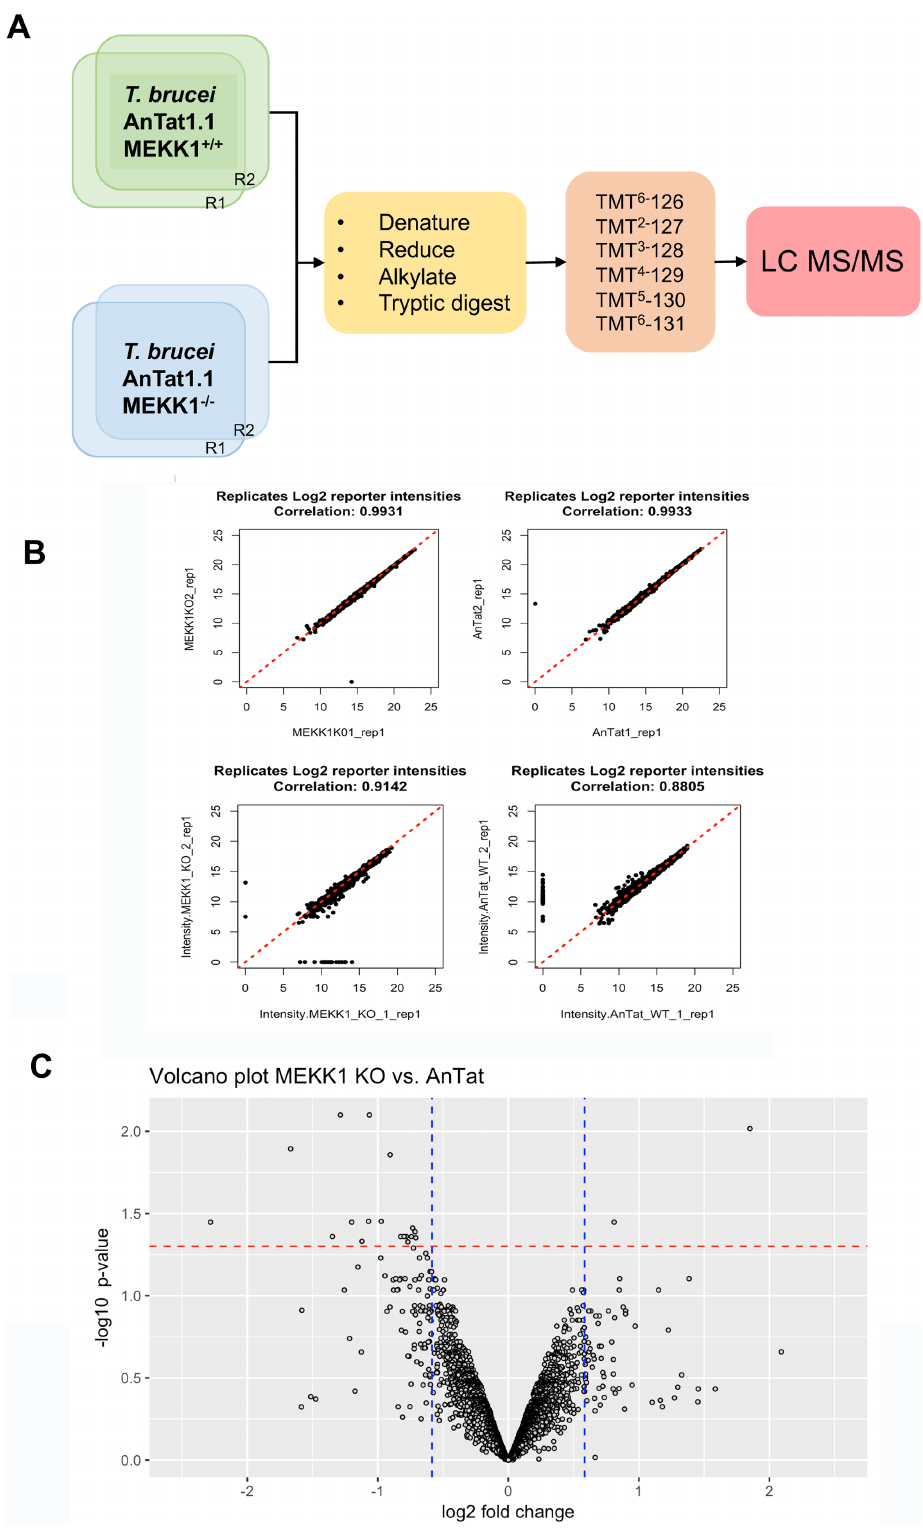
Fig 9. Phosphoproteomic analysis of a MEKK1 null mutant. A. Experimental approach. T . brucei EATRO 1125 AnTat1.1 90:13 and MEKK1 null mutants were grown in culture and harvested after identical growth profiles and